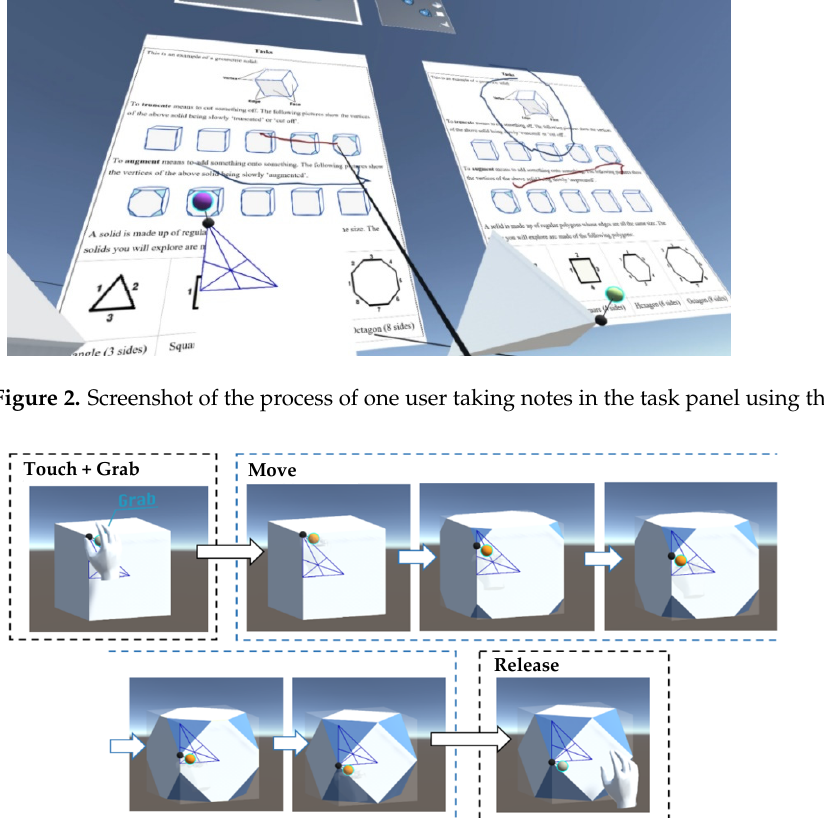
Figure 3. Screenshots of the process of morphing the shapes: A user grabs the virtual joystick ( top left ) and moves it around ( top right and bottom left ) until reaching the desired object of exploration and finally releases the joystick ( bottom right ).